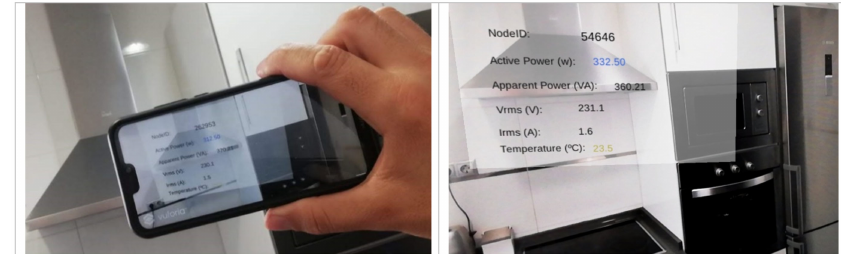
Figure 6. The screen showed on the smartphone when it focuses on the fume